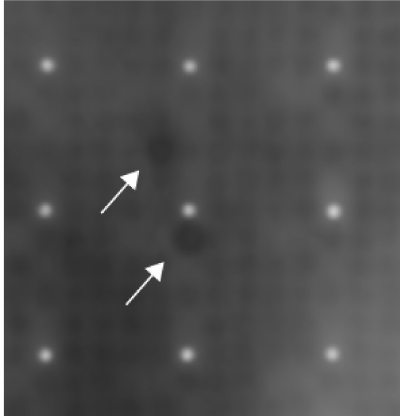
Figure 2. Exemplary result of one of the three protein-arrays using the sera of patients with sarcoidosis. Each white dot is surrounded by 24 grey dots and together they form a cluster within the protein array. The grey dots contain proteins. Each protein can be found at least two times being apart as far as possible in one cluster. In the center of the picture, two dark spots can be spotted. These two dark spots are Negative Elongation Factor E (white